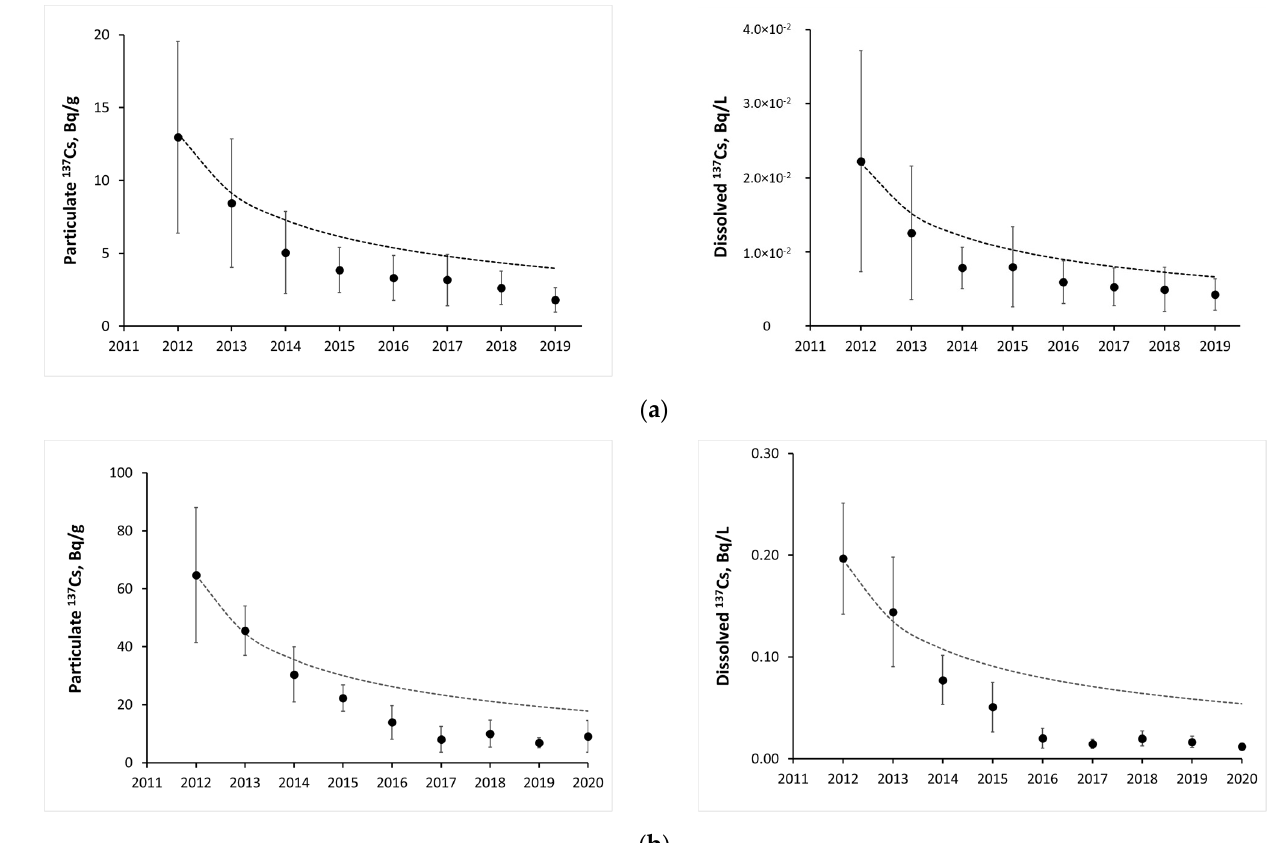
Figure 6. Time changes of particulate and dissolved 137 Cs in two rivers of Fukushima-contaminated area: ( a ) annual mean particulate dissolved 137 Cs activity concentrations in Abukuma River at Kuroiwa (Fukushima city) in 2012–2019 based on the data of [99] against diffusional model prediction (dotted line); ( b ) annual mean particulate and dissolved 137 Cs activity concentrations in Hiso River in 2012–2020 based on the data of [100] against diffusional model prediction (dotted